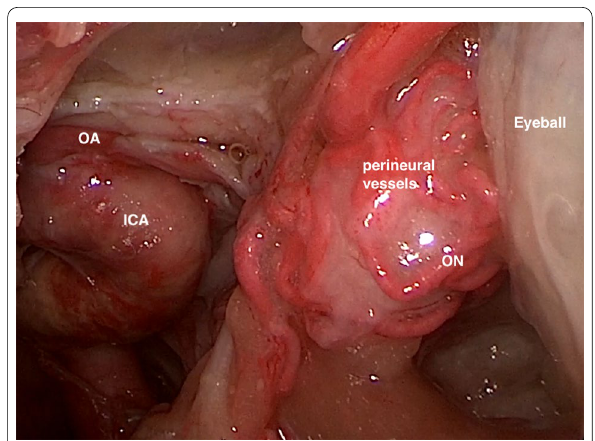
Fig. 4 Cadaver endoscopic anatomical exemplificative view. It is possible to appreciate how in the distal segment of the optic nerve (ON), contiguous to the posterior portion of the eyeball, the perineural vessels surround the sheath together with the fat. Instead, in the proximal segment, the optic nerve is contiguous to the ophthalmic artery (OA), which runs parallel to the internal carotid artery